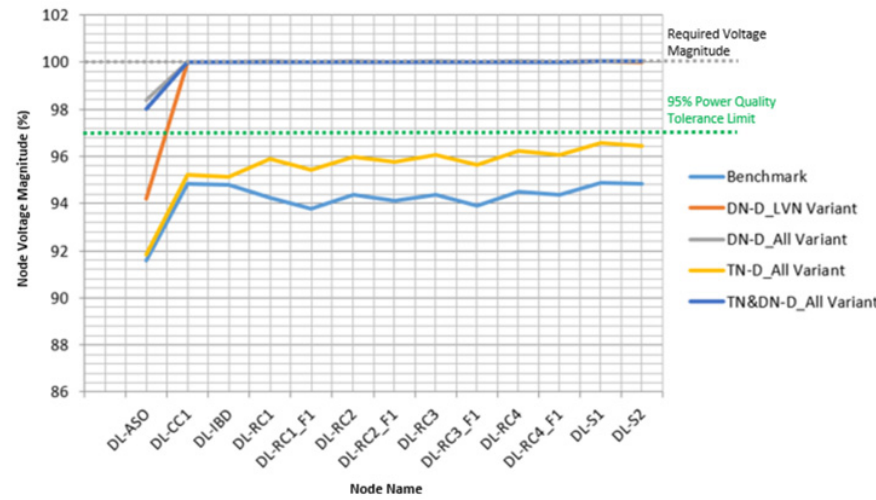
Figure 5. Graphical representation of relative improvement in voltage magnitude arising from variants employing Distributed ESS Integration Architecture.